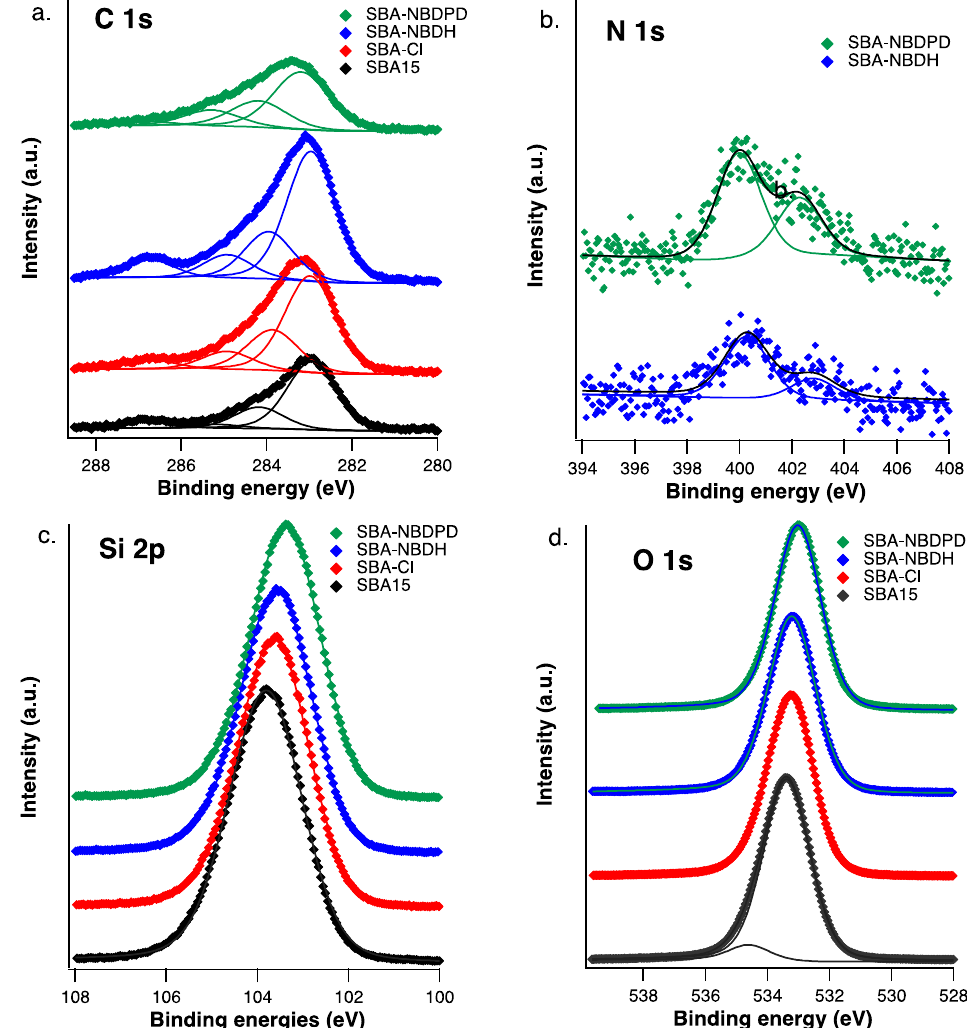
Figure 6. High-resolution spectra for C1s ( a ), N1s ( b ), O1s ( c ), and Si 2p ( d ) core levels.